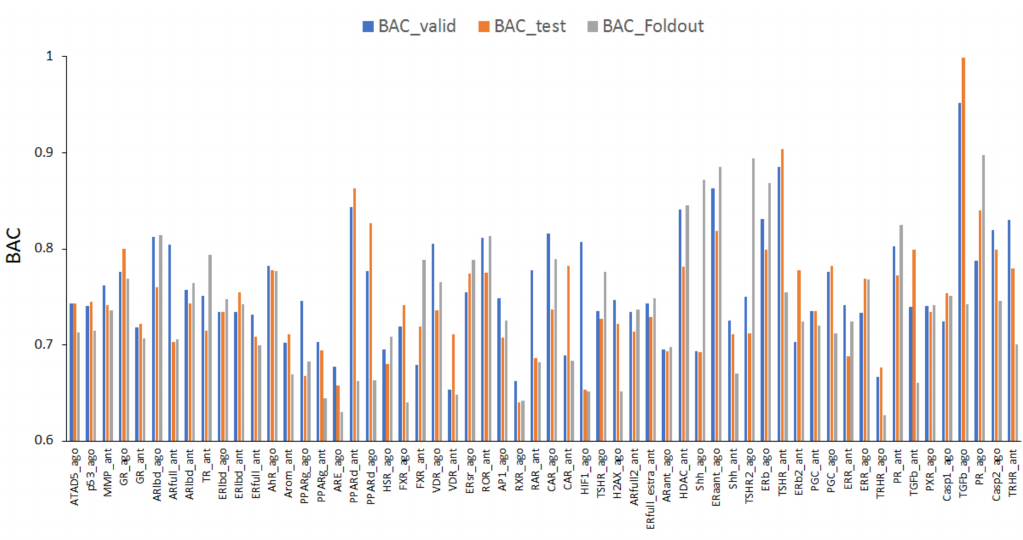
Figure 2. Balanced accuracy (BAC) of 59 key molecules in MIEs on the validation, test, and foldout datasets. The model exhibiting the highest prediction performance was selected out of six angles in